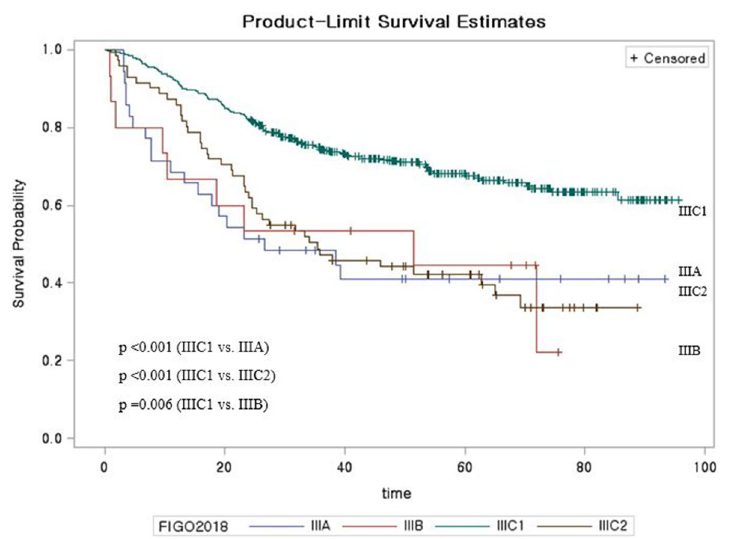
Figure 2. Kaplan–Meier analysis of survival for 2018 FIGO stage